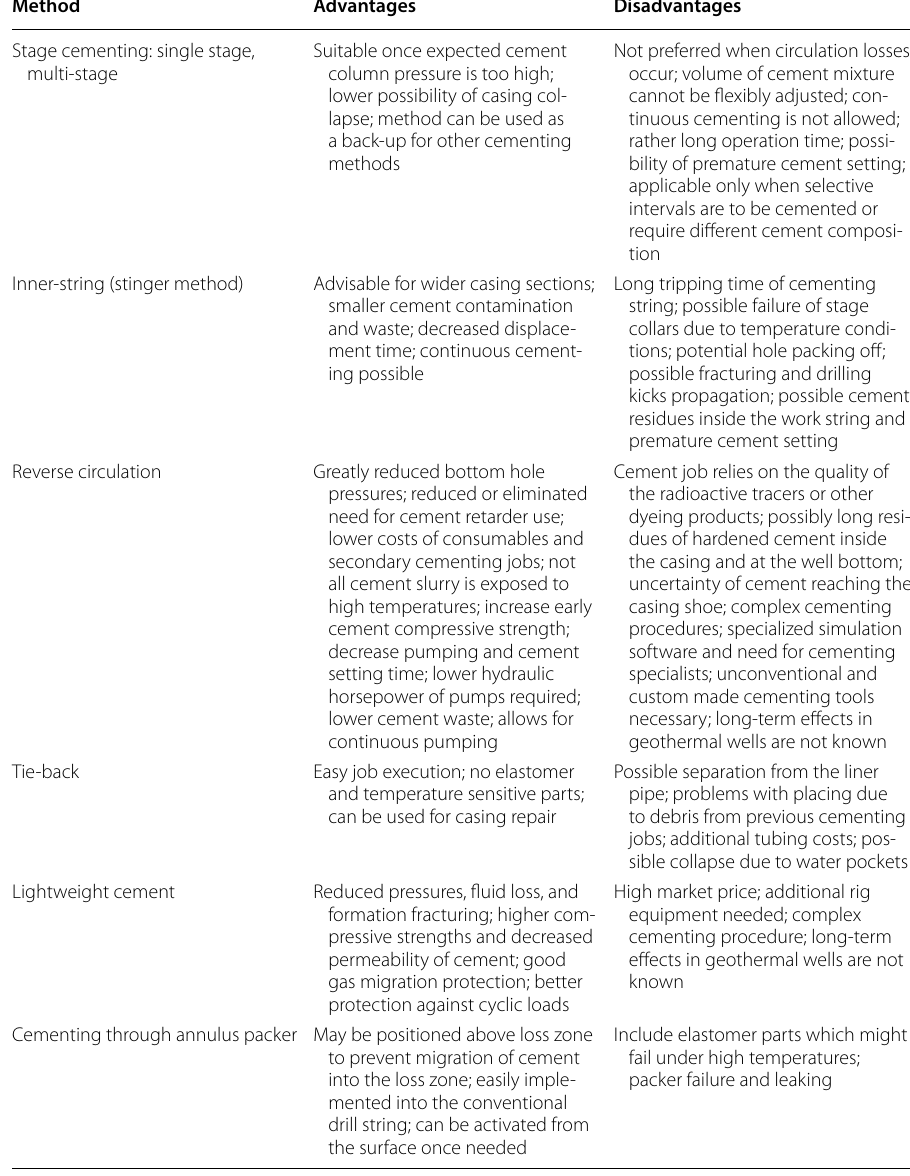
Table contains results from Ingason et al. (2015) and the state of knowledge of the authors